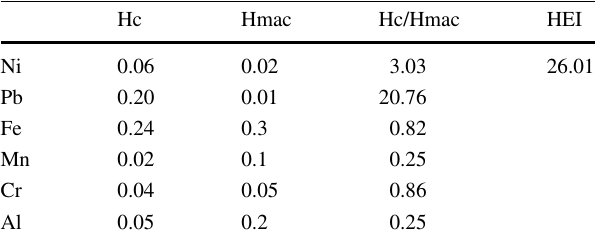
Table 5 Heavy metal evaluation index for groundwater at site 3